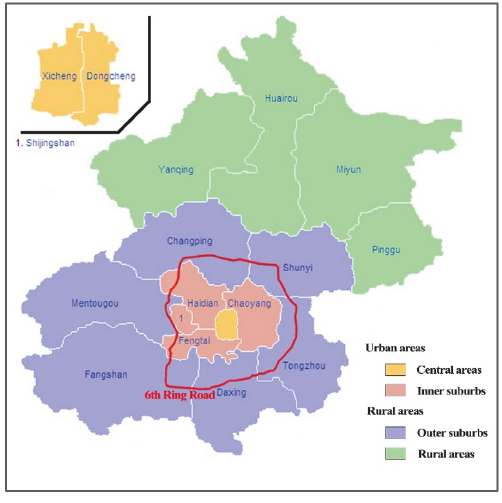
Figure 1: The study area in Beijing,